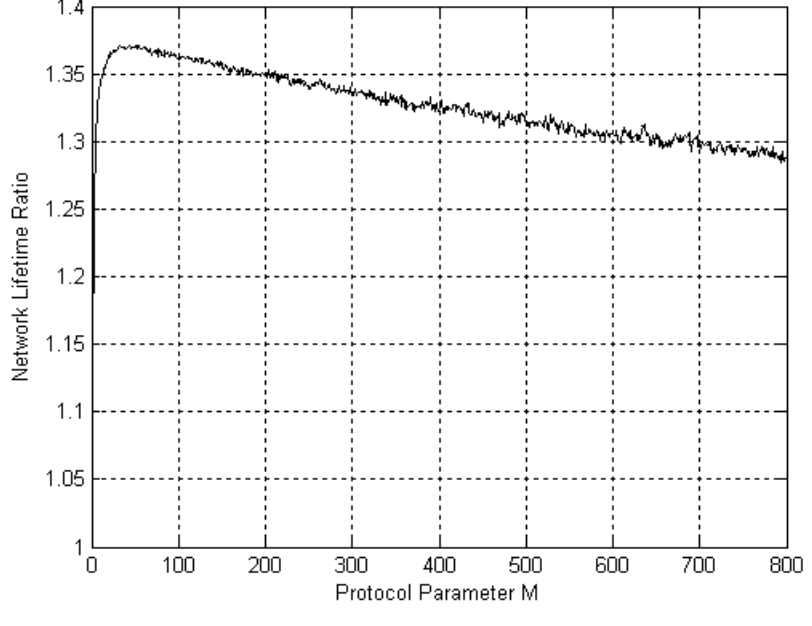
Figure 10. Effect of M on improvement in Network Lifetime. Note that highest improvement is obtained for 10 < M < 110 .